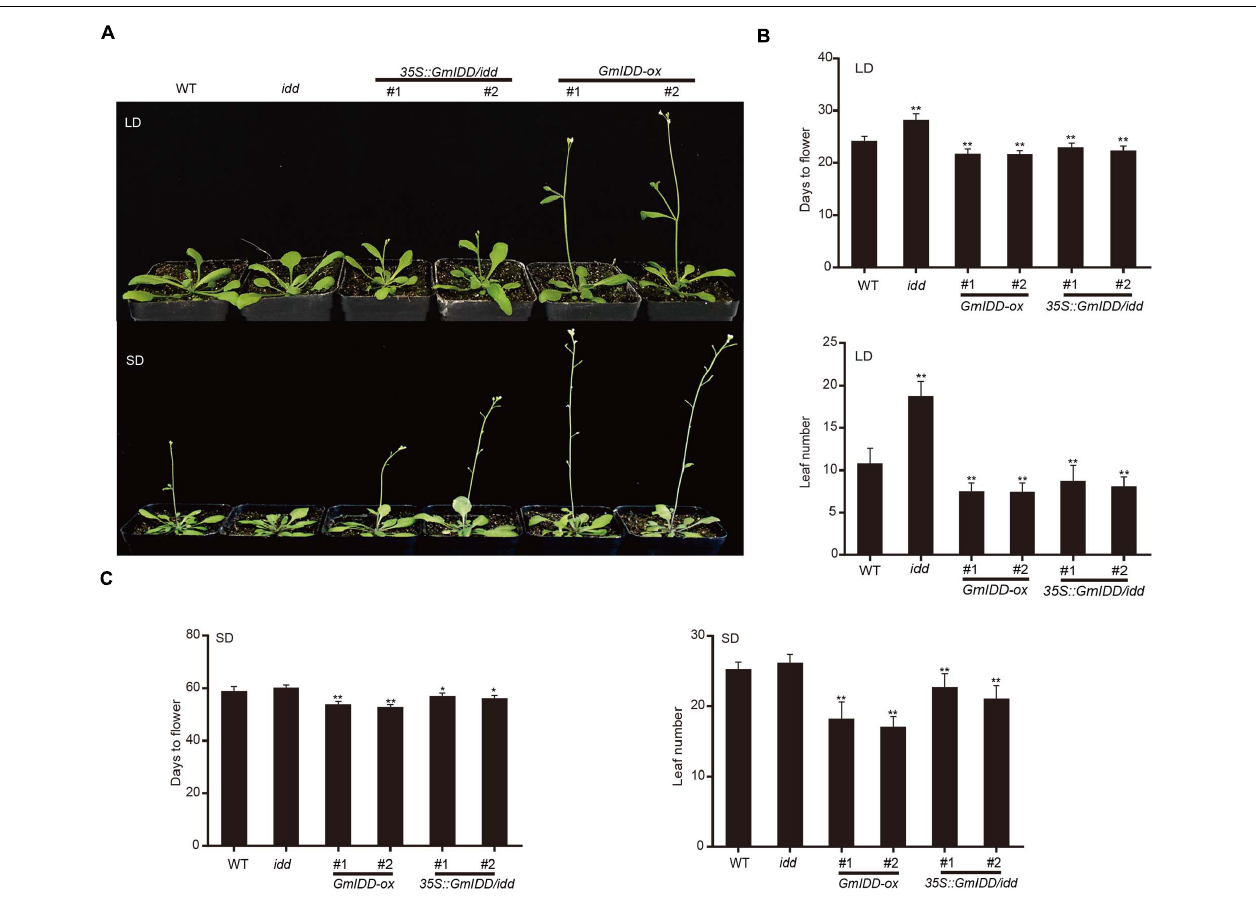
FIGURE 3 | GmIDD conferred early flowering phenotypes in transgenic Arabidopsis. (A) Flowering phenotype of GmIDD plants under LDs and SDs. GmIDD-ox , idd mutant, 35S:GmIDD / idd restoration and WT Arabidopsis plants were cultured under LDs and SDs. Photographed after the plants have grown in the soil under LDs and SDs for 25 days and 56 days, respectively. (B) Days to flowering and average total leaf numbers of GmIDD-ox , idd mutant, 35S:GmIDD/idd restoration and WT Arabidopsis plants under LDs. (C) Days to flowering and average total leaf numbers of GmIDD-ox , idd mutant, 35S:GmIDD/idd restoration and WT Arabidopsis plants under SDs. Data represent means ± SD of at least 20 seedlings. Asterisks indicate significant differences between GmIDD-ox , idd mutant, 35S:GmIDD/idd restoration plants and WT. For each experiment, three technical replicates were conducted. Data shown are mean ± SD of three independent experiments (* P < 0.05 and ** P < 0.01, Student’s t